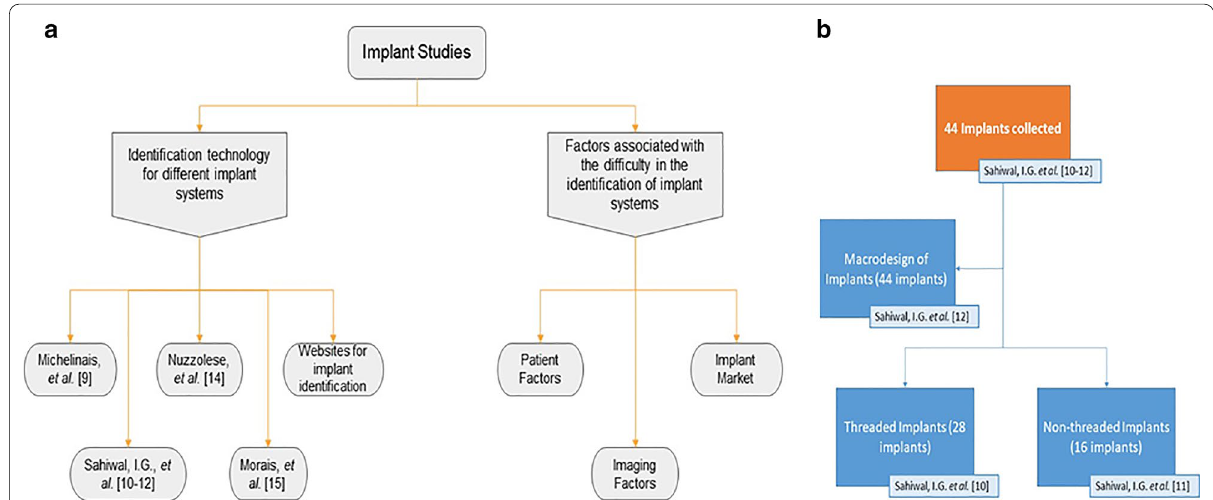
Fig. 1 a Schematic of the studies involved in the review; b Three studies conducted by Sahiwal et al. (Sahiwal et al. 2002a; Sahiwal et al. 2002b; Sahiwal et al. 2002c) describing different types of implants: Threaded and Non-threaded including the macro design of